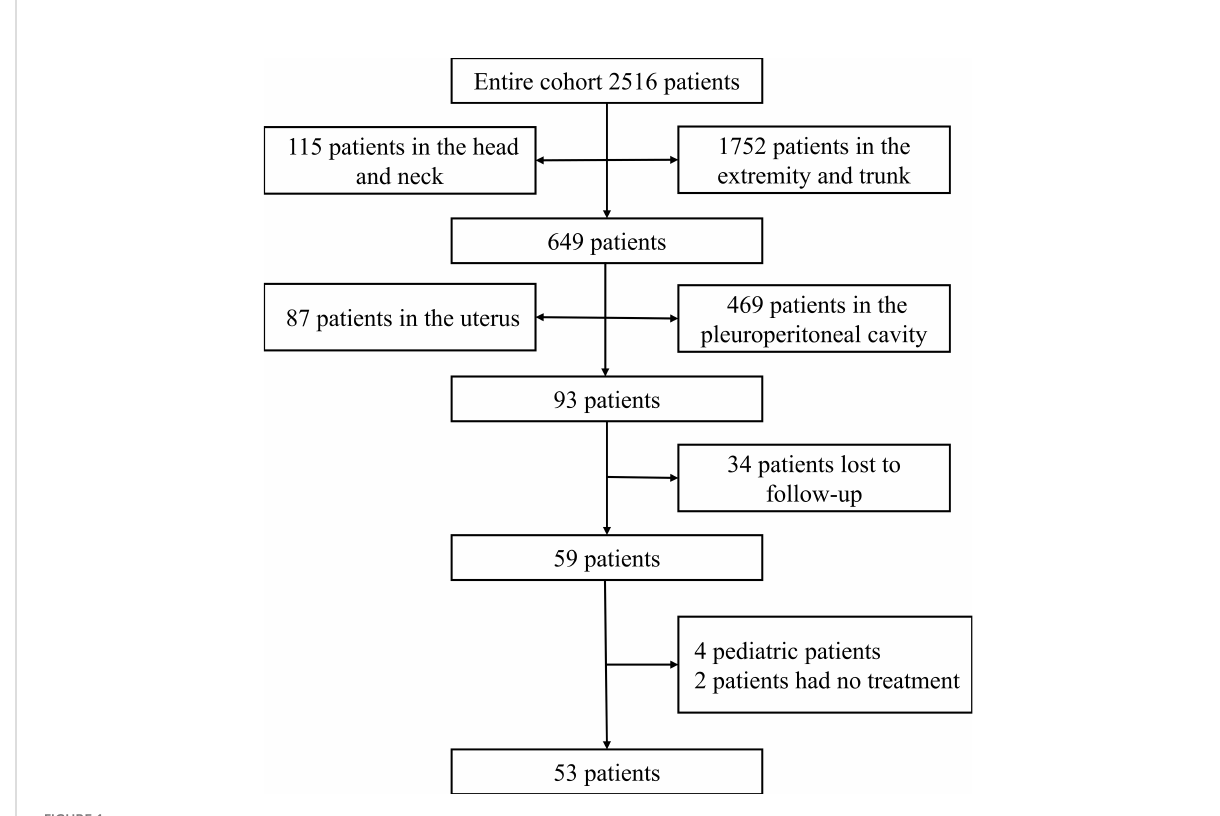
FIGURE 1 Flowchart of the selection of study